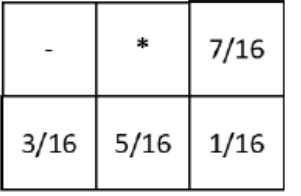
Figure 7. Floyd and Steinberg error diffusion